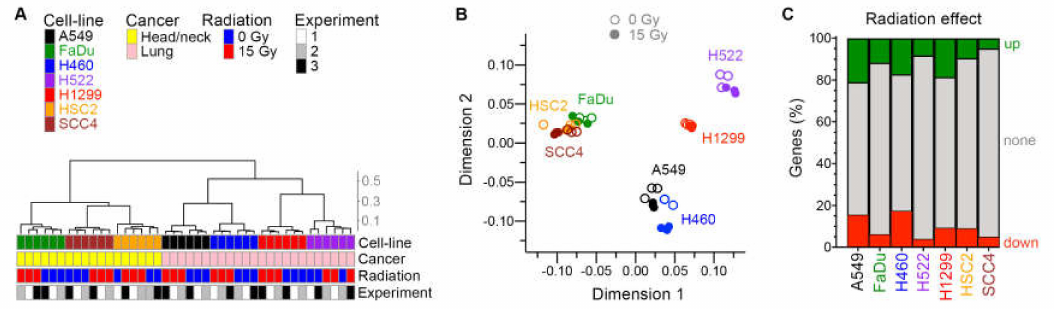
Figure 5. E ff ect of radiation on transcriptome. For seven human cancer cell lines, gene expression in adherent cells four days after radiation treatment was examined in three experiments with paired cell culturesthatwereorwerenottreatedwithonedoseof15GyX-rays. Similarityamongthetotal42cellular transcriptomes is illustrated with unsupervised hierarchical clustering ( A ) and multi-dimensional scaling ( B ) plots. Cosine distance and Ward agglomeration methods were used. Inter-cluster distances in the dendrogram are indicated with a scale. ( C ) E ff ect of radiation on expression of genes in each cell line is depicted with stacked barplots that show the fractions of genes of which expression was up- or down-regulated ≥ 1.5-fold at 0.05 false discovery rate in paired likelihood ratio test in edgeR. Only a small fraction of genes was a ff ected by radiation in same manner in all seven cell lines. There were 102 downregulated genes in common (Table S2), 44 of which encode histones and